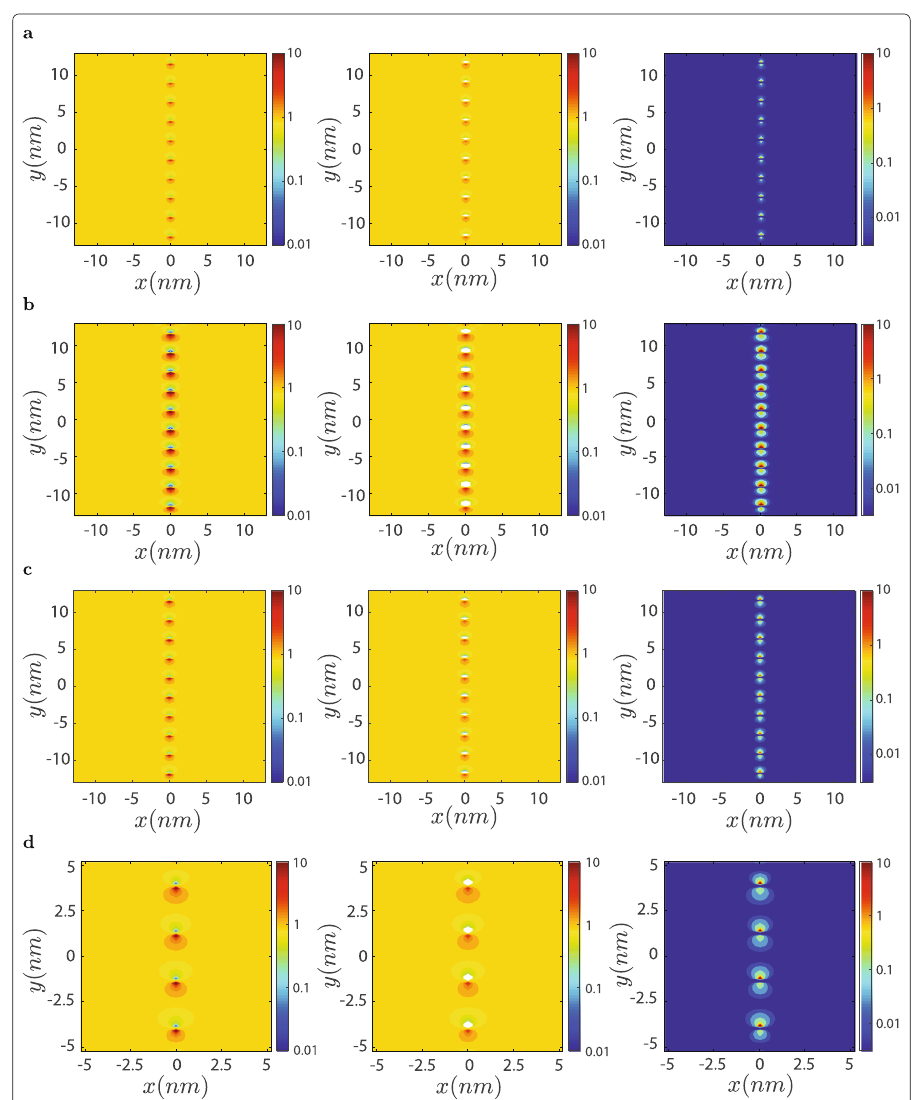
Fig. 7 Contour plots of the normalized H concentration, χ/χ 0 , for as calculated from (left column) the direct numerical solution of Eq. (7) and (middle column) the linearized solution given by Eq. (10), while the relative error between both solutions is shown on the right column. The simulation parameters are: ( a ) χ 0 = 0.001, L x = L y = 26nm, and T = 1200K; ( b ) χ 0 = 0.001, L x = L y = 26nm, and T = 300K; ( c ) χ 0 = 0.05, L x = L y = 26nm, and T = 1200K; and ( d ) χ 0 = 0.001, L x = L y = 10.4nm, T =